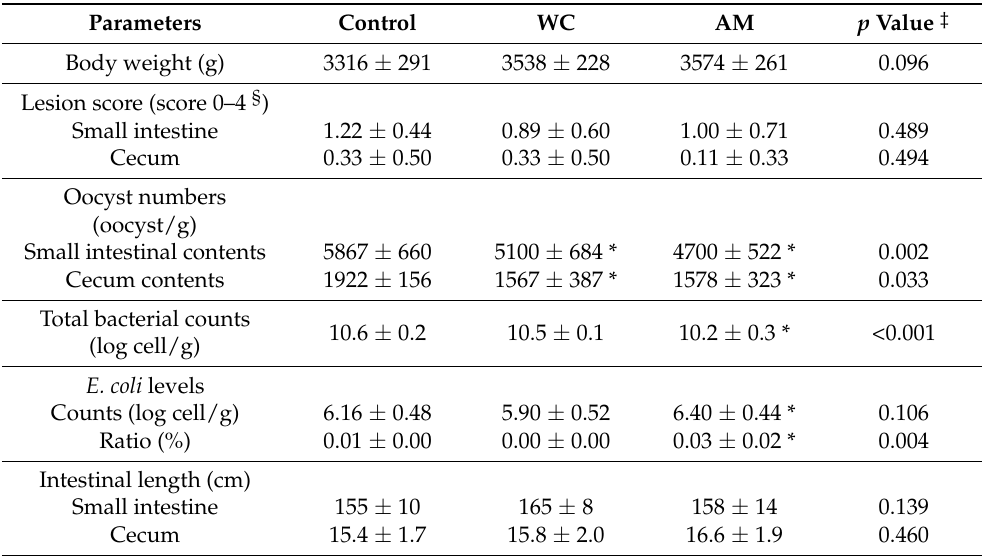
Table 3. The body weights, lesion scores, oocyst numbers, total bacterial counts, E. coli levels, and intestinal lengths of the broiler chicks slaughtered at 49 days of age. Parameters